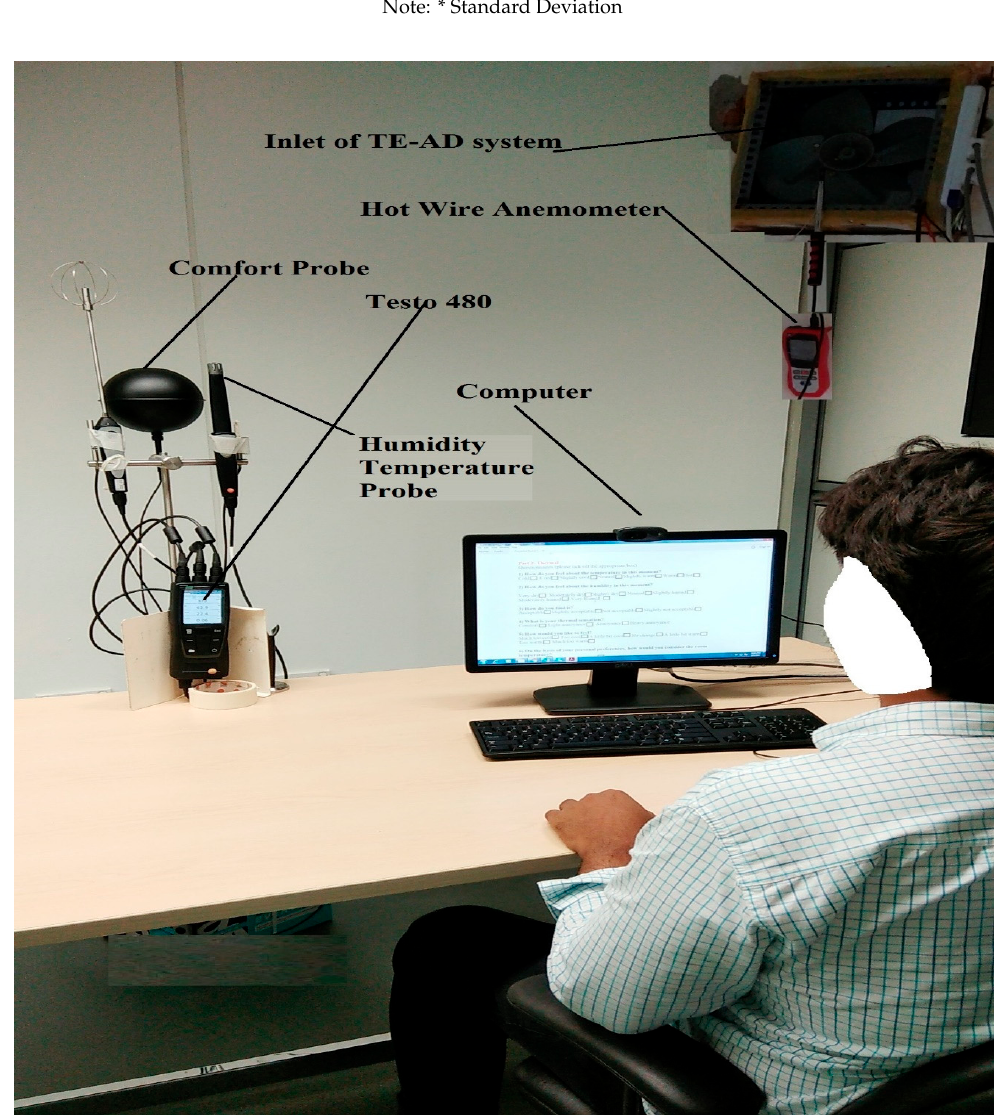
Figure 1. A study occupant registering his subjective opinion before the start of sleep experiment. Table 1. Anthropometric data of subjects.